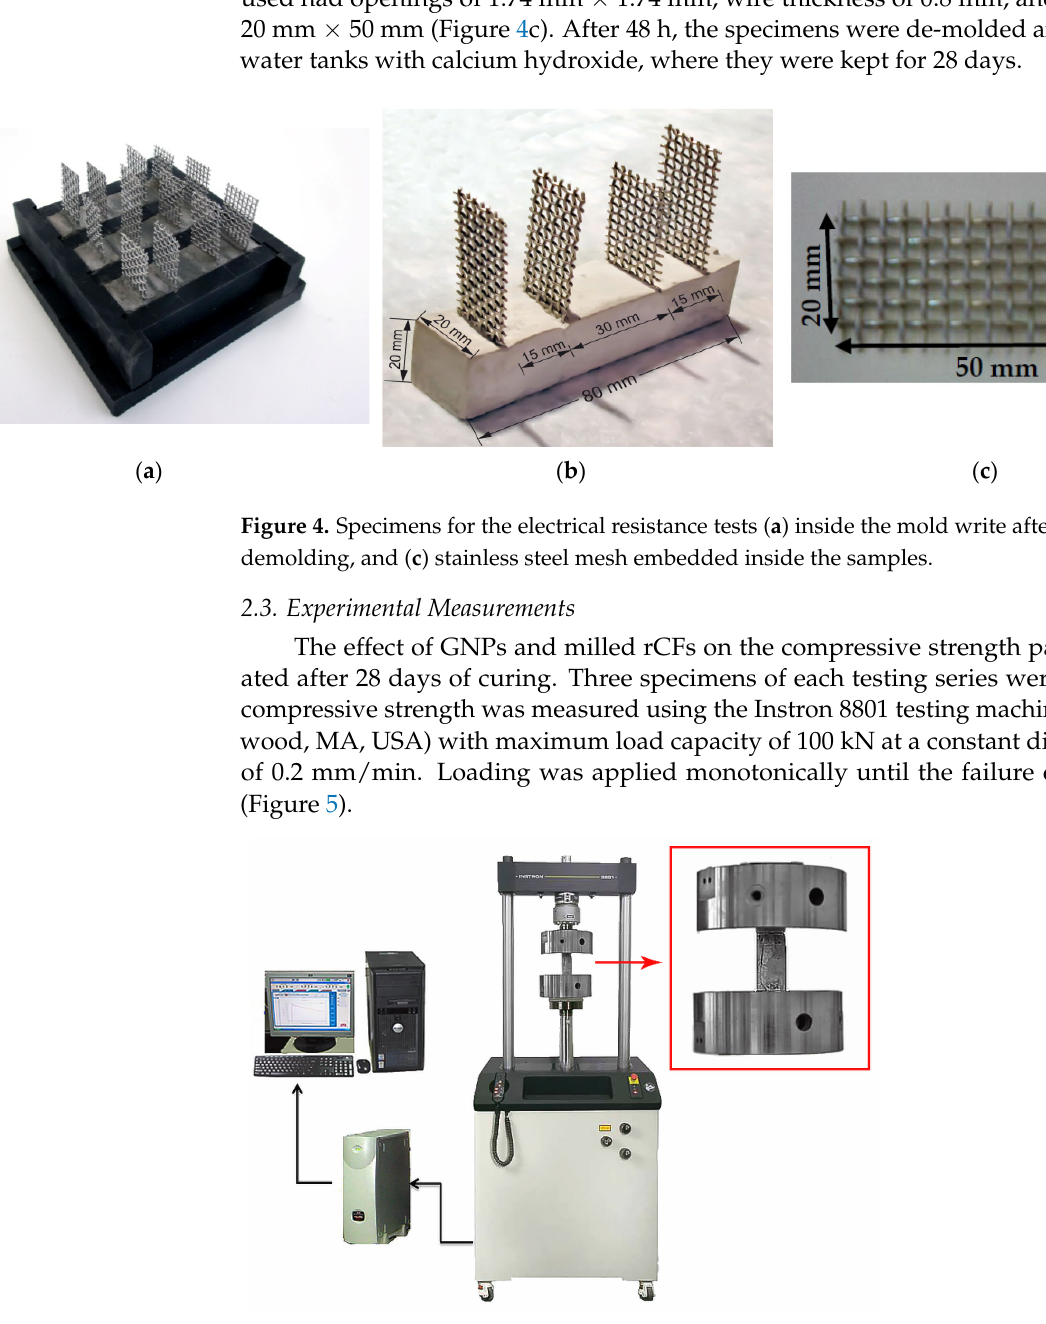
Figure 5. Experimental apparatus for compressive stress test (close up shows a fractured sample). The effect of GNPs and milled rCFs on the flexural strength of the cement paste was evaluated after 28 days of curing. Flexural strength measurements were carried in a 4-point-bending configuration (Figure 6) using an MTS Insight testing machine (MTS Systems Corporation, Eden Prairie, MN, USA) with maximum load capacity of 10 kN applying a constant displacement rate of 0.002 mm/min (Figure 4b). The average flexural strength of three specimens was recorded and presented as representative flexural strength of the cement